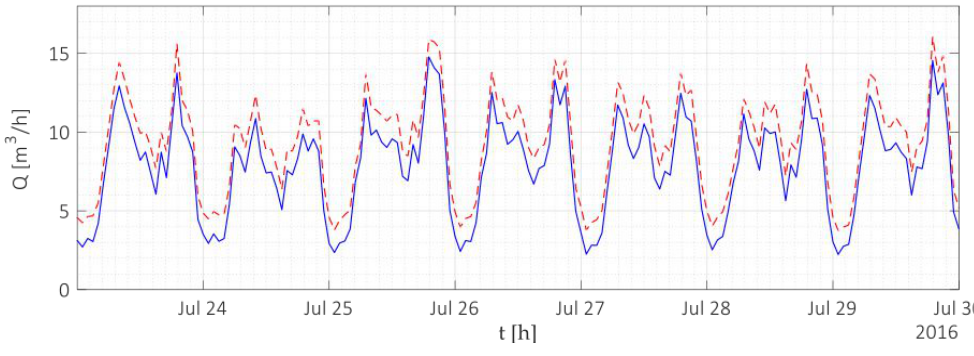
Figure 10. Water balance with reference to the district metered area of Gorino Ferrarese (FE) in July 2016.